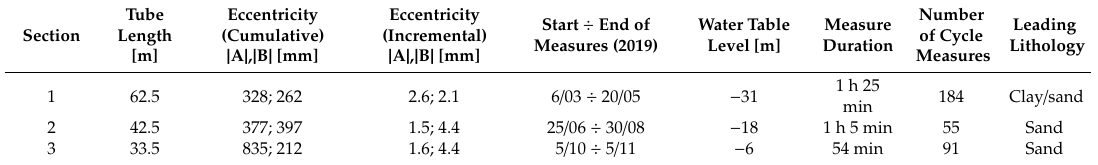
Table 2. Main characteristic of the inclinometer tubes installed. The cumulative eccentricity was calculated on the top of the borehole and the incremental value is a mean for each depth (every 50